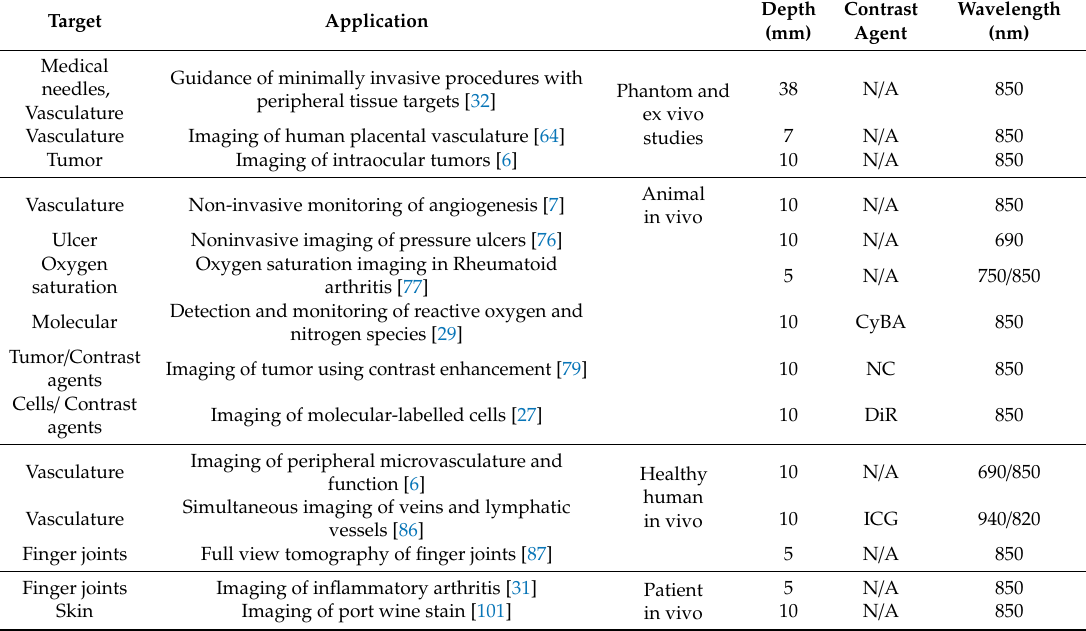
Table 3. Summary of preclinical and clinical applications of LED-based